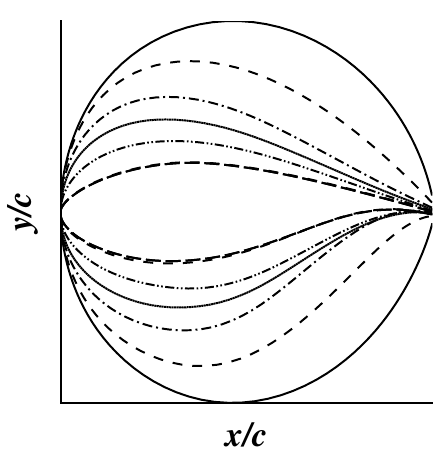
Figure 4. Visualization of the sectional airfoils employed in the Advanced Aerodynamic Tools for Large Rotors (AVATAR) blade.